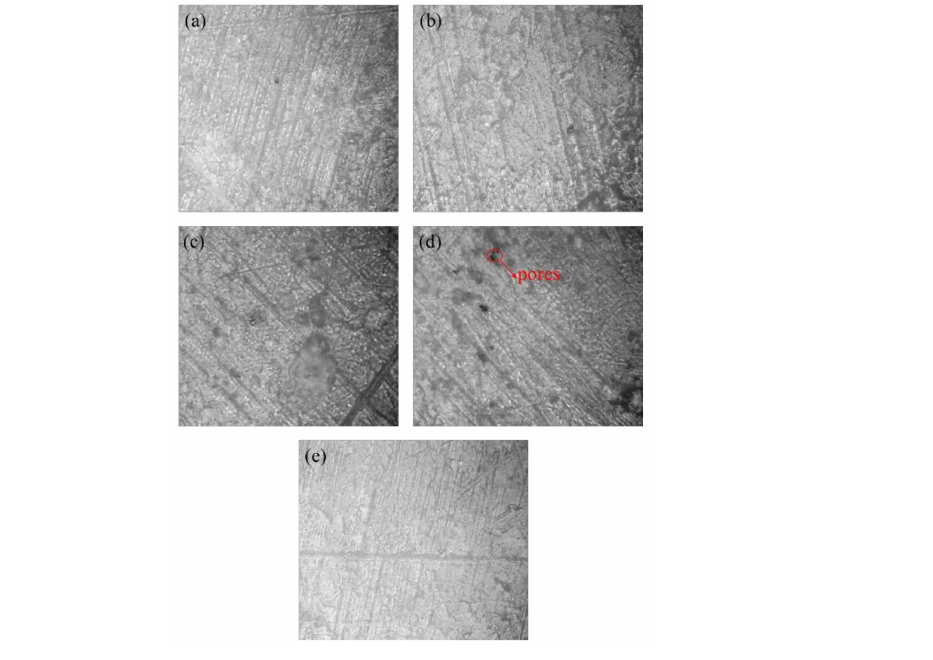
Figure 12. Microstructures at the upper surface of the PEKK compacts at various initial relative densities: ( a ) ρ 0 = 0.4352; ( b ) ρ 0 = 0.4485; ( c ) ρ 0 = 0.4377; ( d ) ρ 0 = 0.2558; ( e ) ρ 0 =